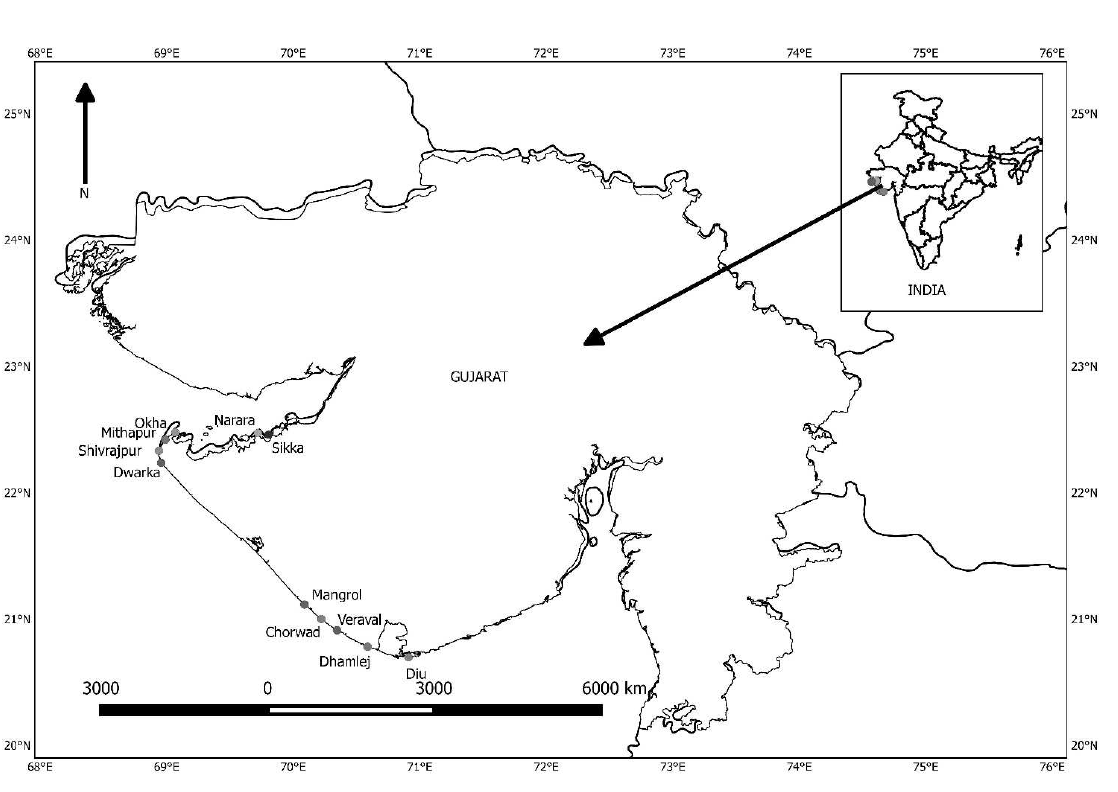
F IGURE 1. Map of the studied